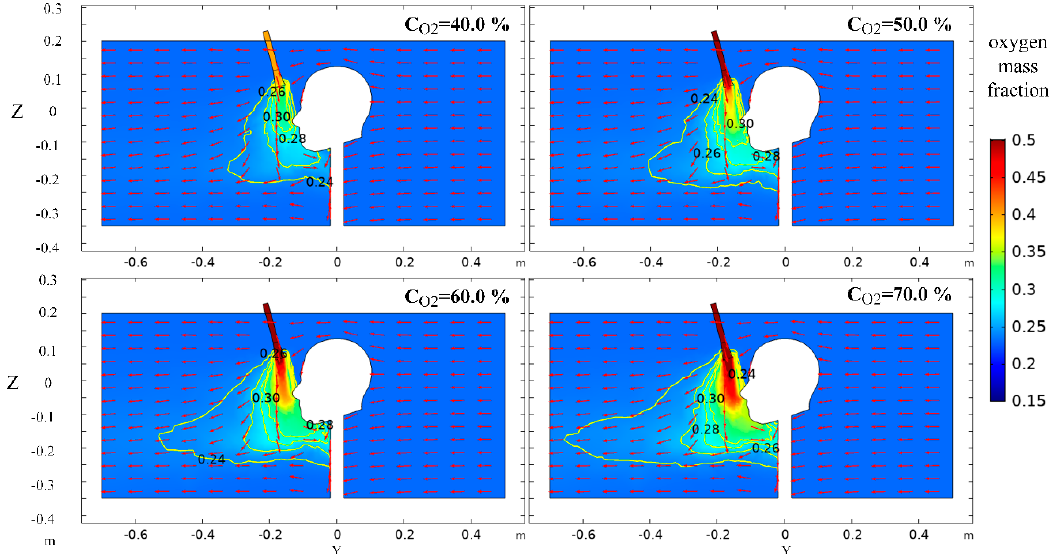
Figure 10. Distribution of oxygen mass fraction in X = 0 m section at different oxygen-supply concentrations.